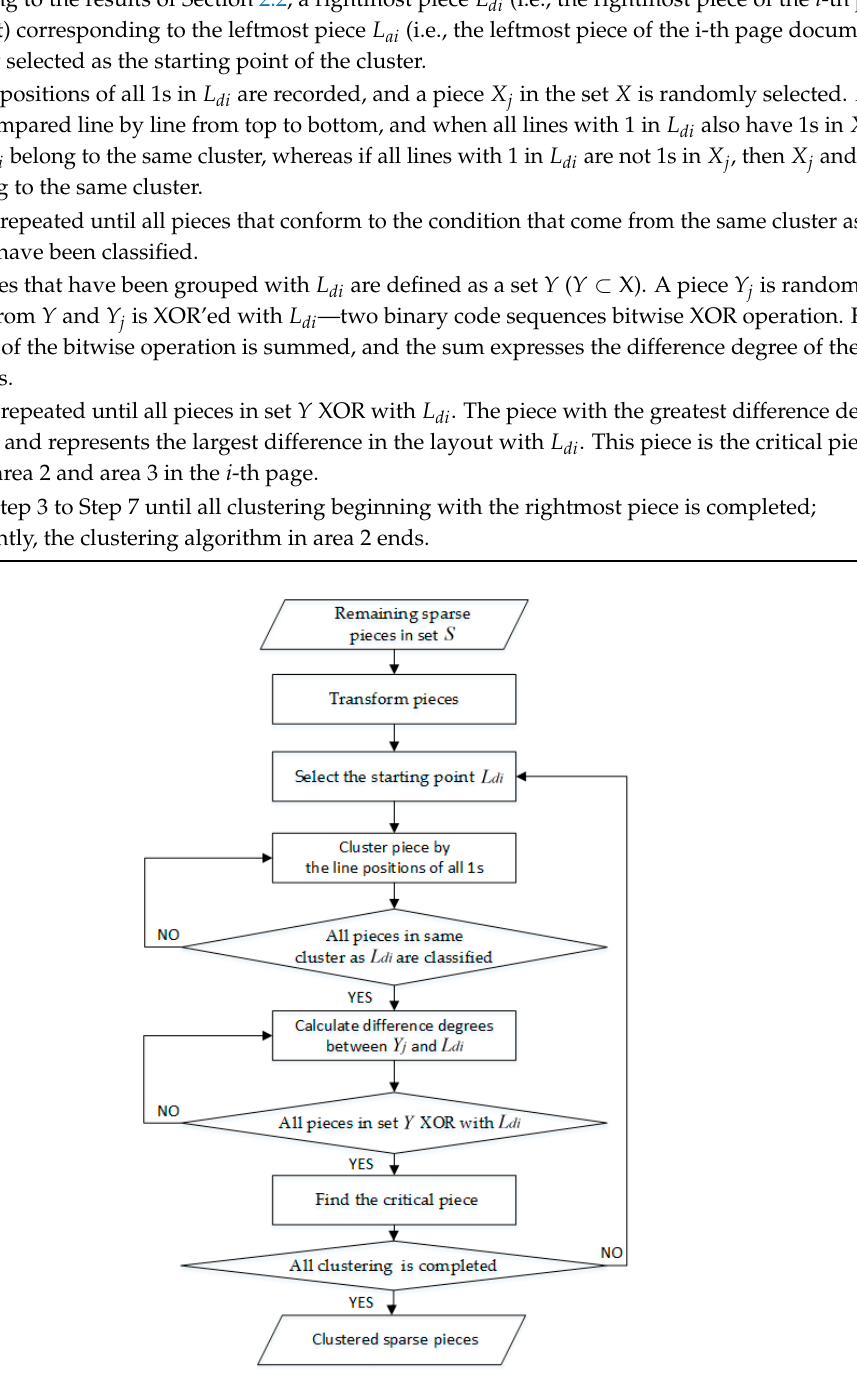
Figure 12. Flowchart of LPC (line position of characters) algorithm.